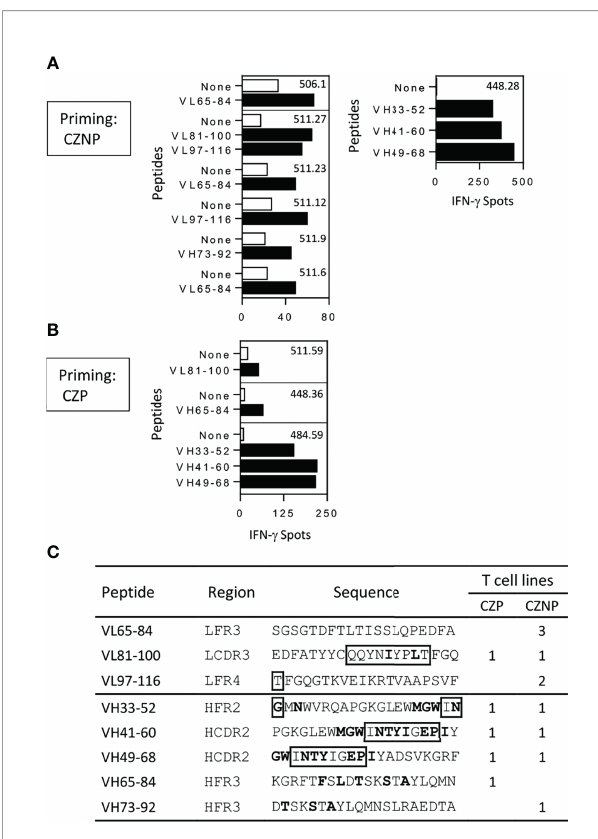
FIGURE 3 | uptake by DCs and proteolytic degradation of certolizumab pegol (CZP) and non-pegylated certolizumab (CZNP). (A) Labelled CZP (2µM) (hatched bars) and CZNP (2µM) (black bars) were incubated with DCs (100 000 cells/200µL) and their uptake assessed by fl ow cytometry (Mean fl uorescent Intensity (MFI). Data presented are the mean of 5 independent experiments carried out with cells produced from different donors (B) In vitro kinetic degradation of Fabs by Cathepsin (B) a: Fab. b: Fab + DTT. c: Fab without enzyme. Time is expressed in